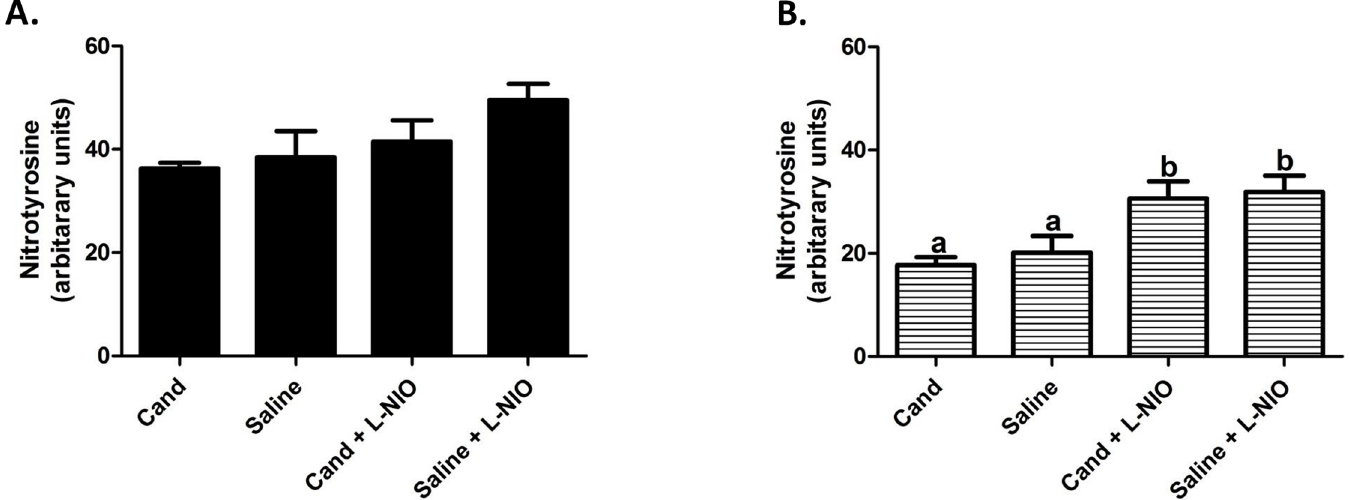
Fig 6. eNOS inhibition alters nitrosative stress levels after stroke. Acute L-NIO treatment did not affect the nitrosativestress levels in the ipsilateral hemisphere ()(A). In contrast, L-NIO inducedan increasednitrosative stress in the contralateralhemispheres of both candesartanand saline treated animals (F = 4.76, df = 3;p = 0.008)(B). a, b Pairs of means with different letters are significantlydifferent from each other. Data presented as mean ± SEM;n = 6–8 per